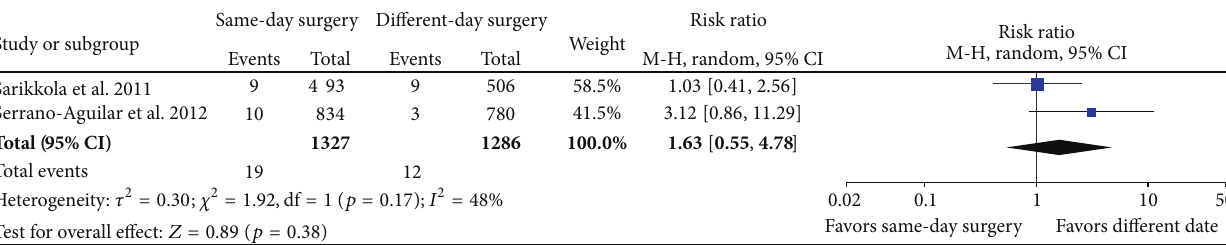
Figure2:Forestplotofnumberofseriouspostoperativecomplications(cornealedema,macularedema,woundleak,oririsprolapse)detected within the first month. M-H: Mantel-Haenszel. CI: confidence interval.